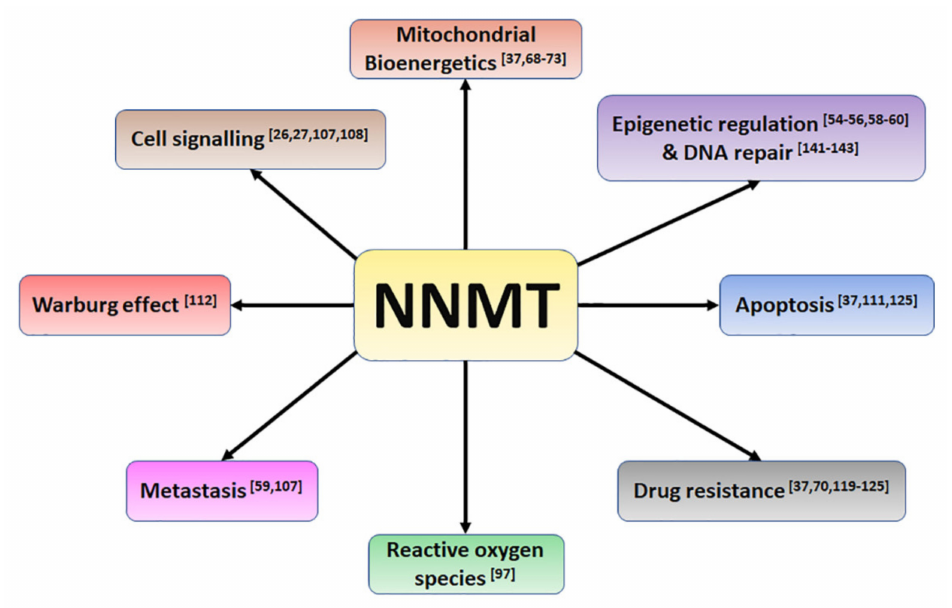
Figure 5. Summary of the pro-oncogenic cellular effects of NNMT expression. Numbers represent citations in the